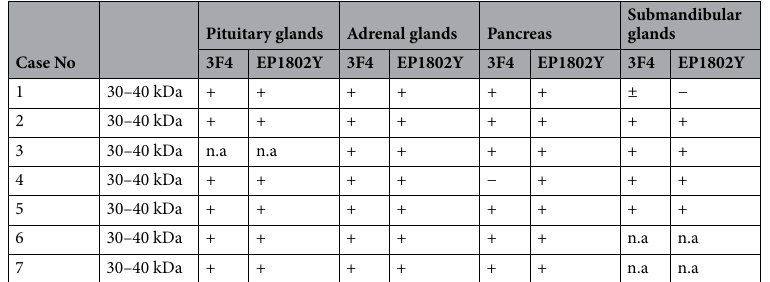
Pituitary glands Adrenal